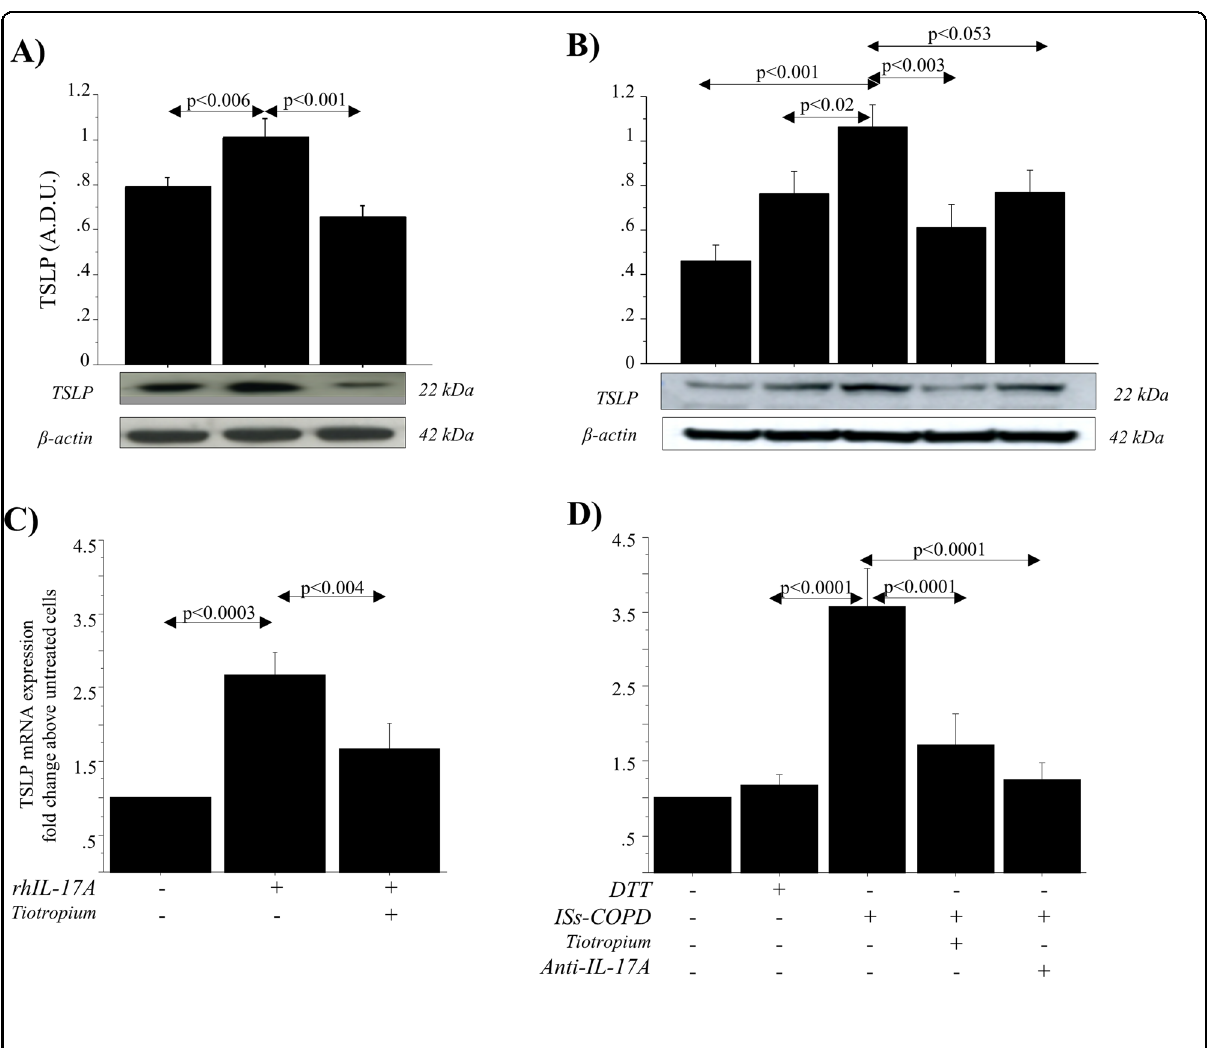
Fig. 3 Effects of anticholinergic drugs on the production of TSLP in 16HBE cells stimulated with rhIL-17A or with ISs from COPD patients. 16HBE cells, in the presence or absence of Tiotropium (100 nM), were stimulated with rhIL-17A (20 ng/ml) or with ISs from COPD patients, untreated or treated with anti-IL-17A antibody, as well as with DTT (vehicle of ISs) ( n = 6 for each experimental condition). a and b show TSLP protein detected by western blot analysis as described in the “ Materials and methods ” section. Representative gel images of the experiments are shown. Bars represent the mean ± SD of arbitrary densitometric units (A.D.U.), normalized to β -actin, which was used as the loading control. c and d show TSLP mRNA levels measured by real-time PCR as described in the Materials and Methods section ( n = 3) and expressed as fold-change compared with untreated cells, which were chosen as the reference samples. ANOVA with Fisher ’ s test correction was used to analyze data. A p value < 0.05 was